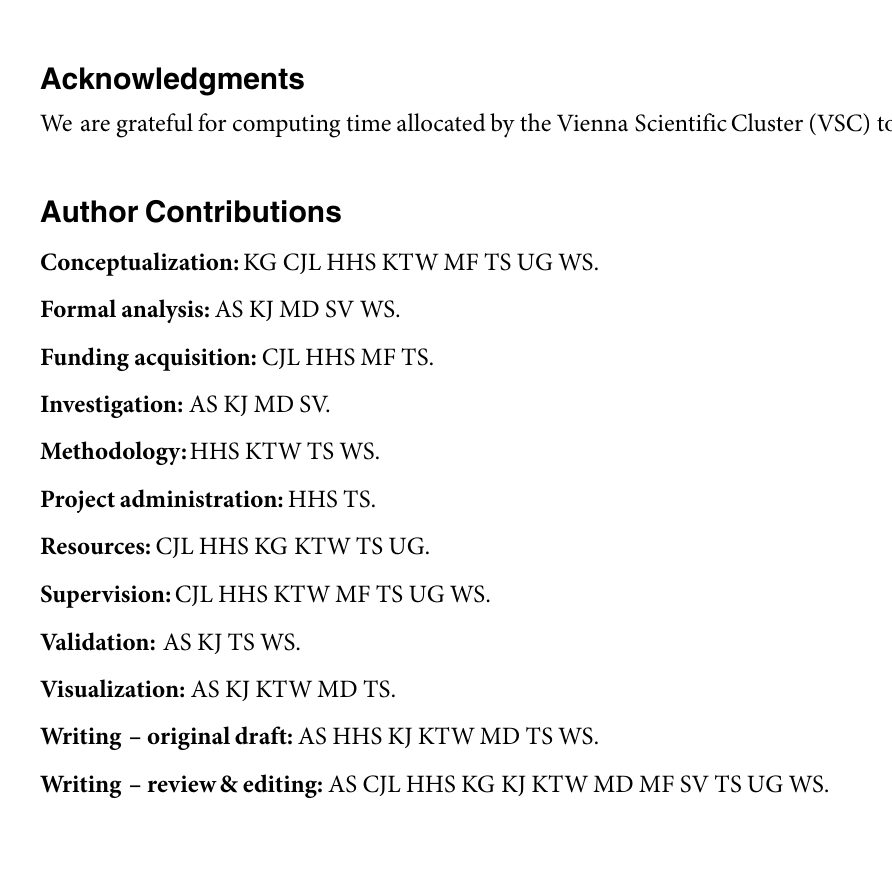
formed in duplicates, error bars denote S.E.M. S7 Fig. Simulation box. Representative final structures for each system are shown for ( A ) the outward-occluded, ( B ) the inward-open system and ( C ) the micelle system containing 140 BOG molecules. LeuT is shown in green ribbon representation, bound sodium ions as green spheres, substrate leucine as green sticks, membrane (POPC) in gray, phosphate atoms as dark spheres, BOG detergent in yellow, the O1 atoms BOG as orange sphere, sodium ions as blue sphere, chloride ions as pink spheres, and water as red-white sticks. S1 Table. Fit-parametersfor the LRET donor decay. Donor emission decays were fit to a sum of two exponentials. The table shows the estimated τ values for the two components along with their respective fractional amplitudes. Each value is the mean of three independent experi- ments performed in triplicates ±